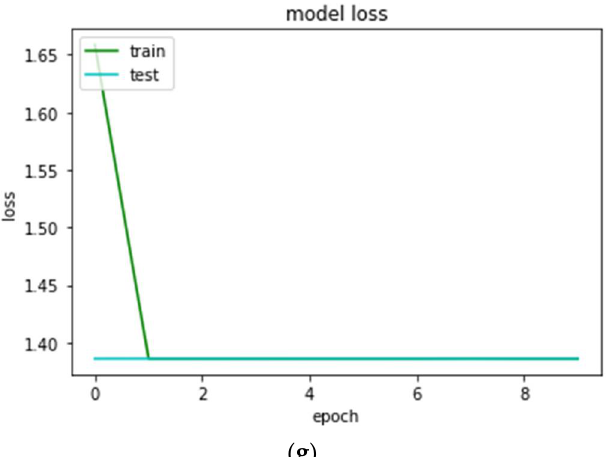
Figure 4. Training and validation loss curves of: ( a ) convolutional neural network, ( b ) DenseNet201, ( c ) EfficientNetB2, ( d ) EfficientNetB0, ( e ) InceptionV3, ( f ) ResNet152, and ( g ) VGG19 models, corre- spondingly, for the facemask coverage classification task. Table 6. Comparative analyses of the proposed scheme with prior